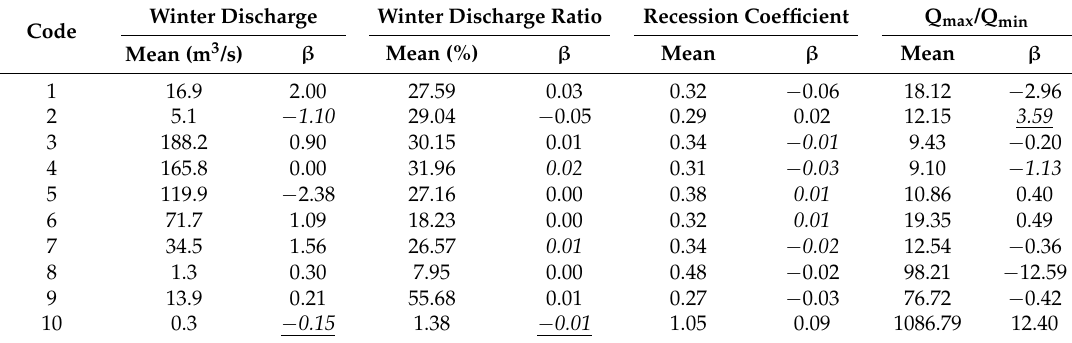
Table 3. Winter discharge, winter discharge ratio, recession coefficient, Q max /Q min and trend analysis results for each discharge